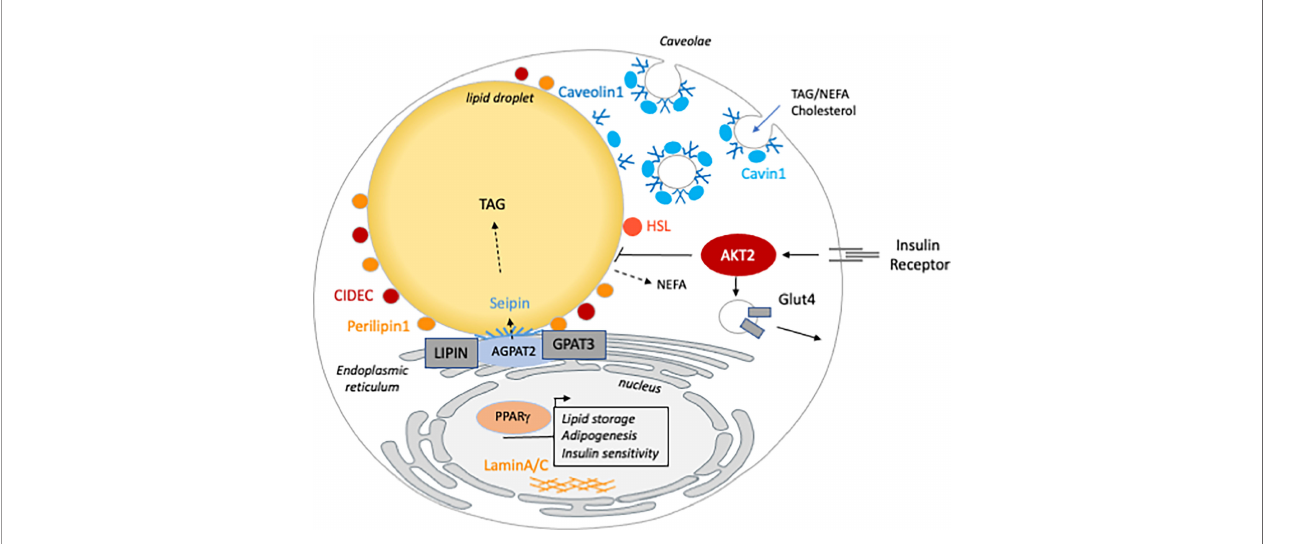
FIGURE 1 | The cellular function of the genes mutated in inherited lipodystrophy. Genes involved in generalized (blue) are involved in TG synthesis (AGPAT2), LD (BSCL2/seipin) or caveolae (Caveolin1 and Cavin1) homeostasis. Partial lipodystrophy causative genes (orange) are involved in different functions of the mature adipocyte. CIDEC, PLIN1 and HSL are LD associated and/or involved in lipolysis regulation. AKT2 and PPARG are both involved in insulin sensitivity. Mutations in LMNA, the gene encoding the nucleophilic lamins A/C, are the most frequent cause of FPLD but how they lead to lipodystrophy remains poorly